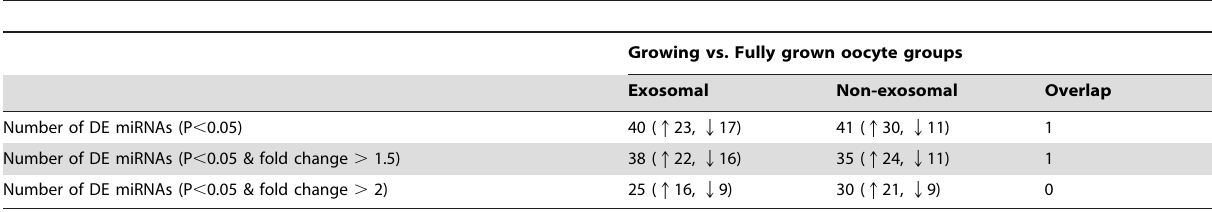
Table 1. Summary of the number of differentially expressed miRNAs obtained from comparisons (growing vs. fully grown) in exosomal and non-exosomal fraction of follicular fluid.